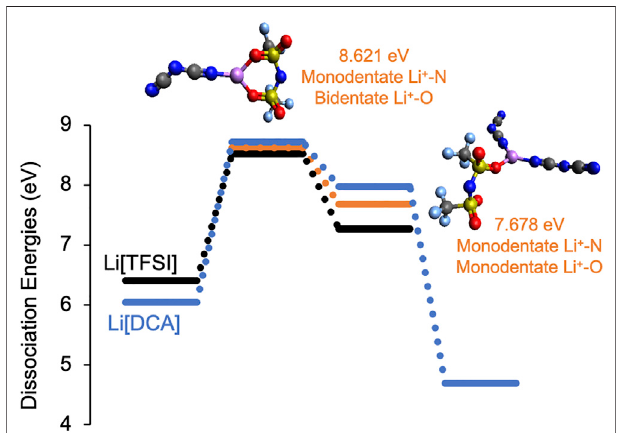
FIGURE 8 | Integral dissociation energies, E D , and representative structures for Li-[CTFSI] solvates (green bars) in comparison to the Li-[DCA]/ [TFSI]mixture(orangebars).Allofthecoordinationenvironmentsarebasedon monodentateLi-Nbonds.Thecolorcodefortheatomsisasfollows:red (oxygen), blue (nitrogen), yellow (sulfur), gray (carbon), purple (lithium), and light blue ( fl uorine).